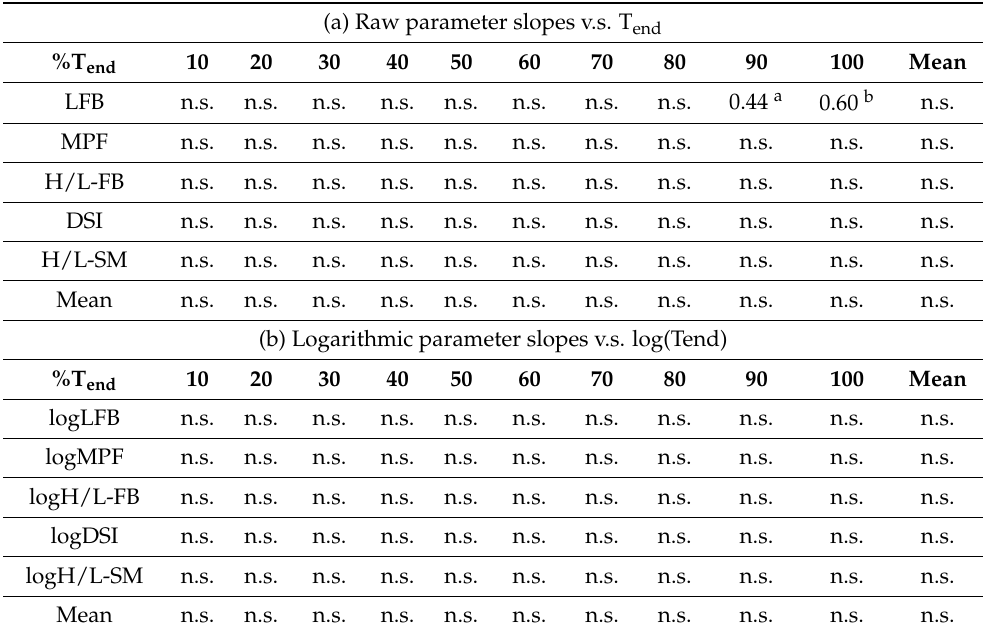
Table 5. Correlation coefficients between the endurance times and area ratios as predictors estimated over the time periods of every 10% of T end